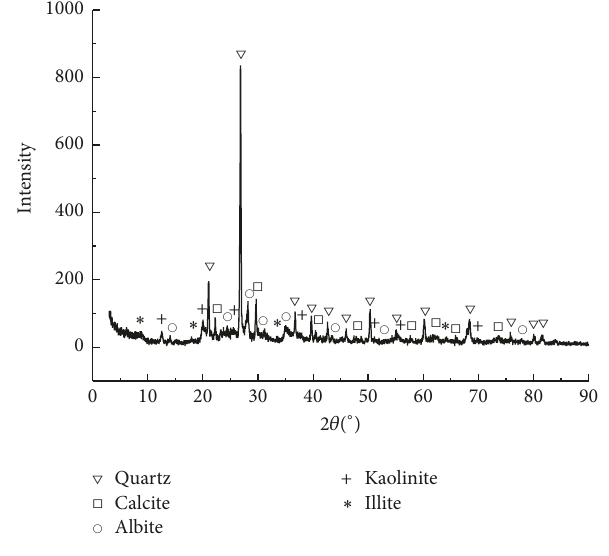
Figure 2: XRD spectrum of